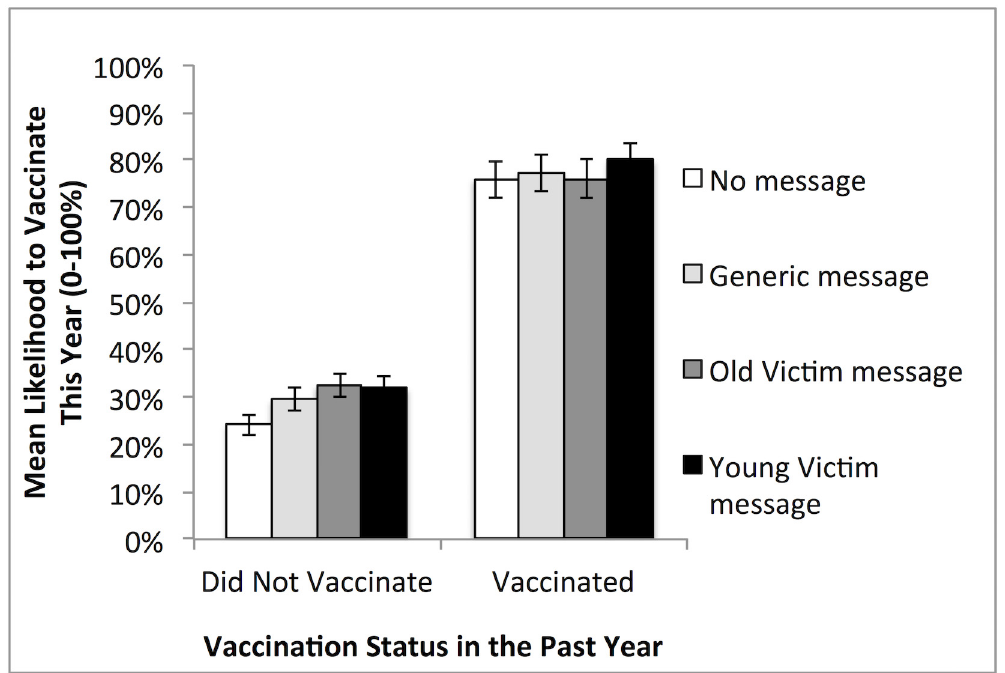
Fig 3. Mean Vaccination Intentions across Condition and Past Year Vaccination Status. Error Bars: ± 2SEs (95% CI).